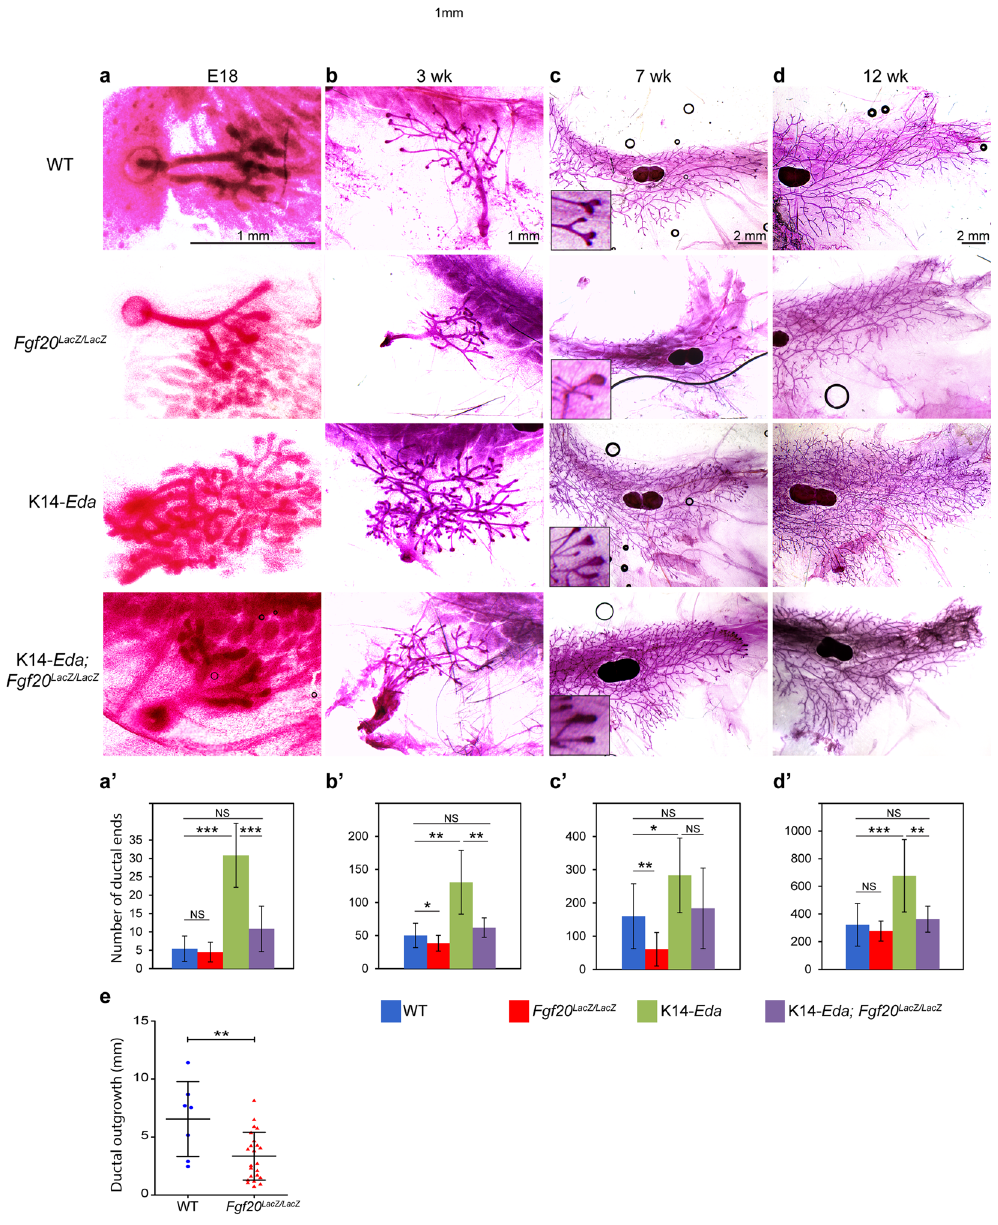
Figure 6. Loss of Fgf20 attenuates the K14- Eda hyperbranching phenotype. ( a–d ) Carmine alum stained 4 th mammary gland of WT, Fgf20 LacZ/LacZ , K14- Eda , and K14- Eda;Fgf20 LacZ/LacZ mice at E18 ( a ), 3 weeks ( b ), 7 weeks ( c ), and 12 weeks of age ( d ). ( a’ – d’ ) Quantification of the total number of end ducts ( a’ , b’ ) or end ducts past the lymph node ( c’ , d’ ) in 4 th mammary gland. Number of glands analyzed were: WT (n E18 = 5, n 3wk = 18, n 7wk = 12, n 12wk = 15) Fgf20 LacZ/LacZ (n E18 = 8, n 3wk = 16, n 7wk = 28, n 12wk = 5), K14- Eda (n E18 = 7, n 3wk = 8, n 7wk = 7, n 12wk = 13) and K14- Eda;Fgf20 LacZ/LacZ (n E18 = 6, n 3wk = 8, n 7wk = 9, n 12wk = 10) ( e ) Ductal outgrowth (mm) measured from center of the lymph node in Fgf20 + / + (n glands = 7) and Fgf20 LacZ/LacZ (n glands = 23). Data are shown as mean ± SD. *** p < 0.001; ** p < 0.01; * p < 0.05; NS, not